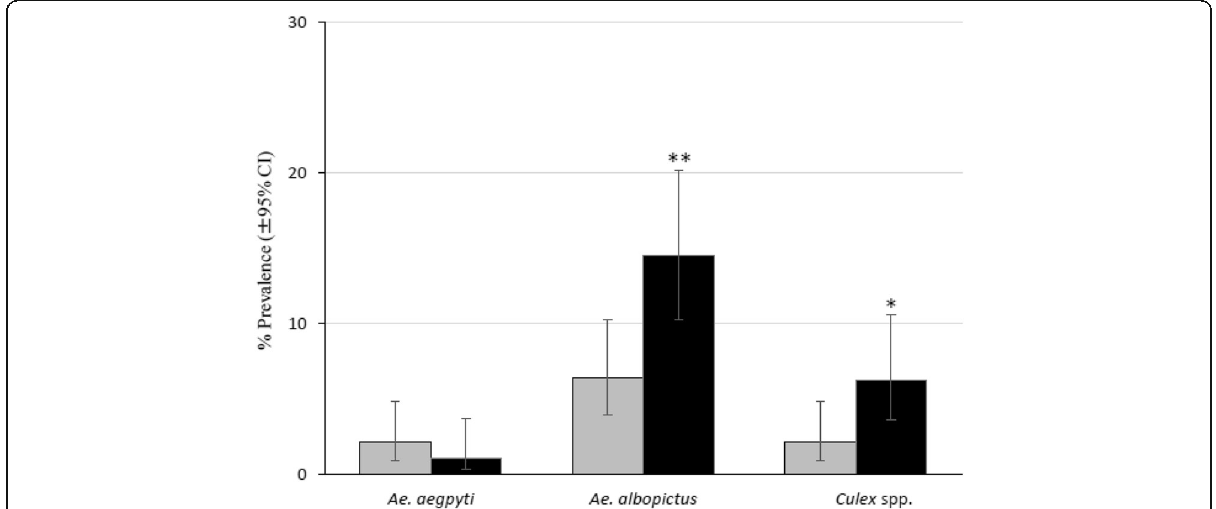
Fig. 6 Relationship between the prevalence of larval species ( Ae. aegypti , Ae. albopictus , and Culex spp.) and the presence/absence of the SumiLarv®2MR disks in the treated village. The containers that contained SumiLarv®2MR disks (number of infestation by Ae. aegypti , Ae. albopictus , and Culex spp., respectively 5, 15, 5; n = 236) and did not contain SumiLarv®2MR disks (2, 28, 12; n = 193) that were obtained in the intervention periods (February, July, and September 2018) were used to analyze. P values were calculated using Fisher ’ s exact test (SumiLarv®2MR disk present vs. SumiLarv®2MR disk absent: * P < 0.05, ** P < 0.01). The grey columns indicated SumiLarv®2MR disk present and the black columns SumiLarv®2MR disk